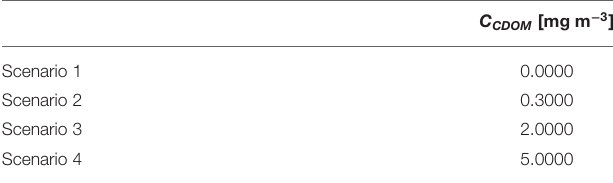
TABLE 1 | Simulated scenarios for CDOM concentration variation.